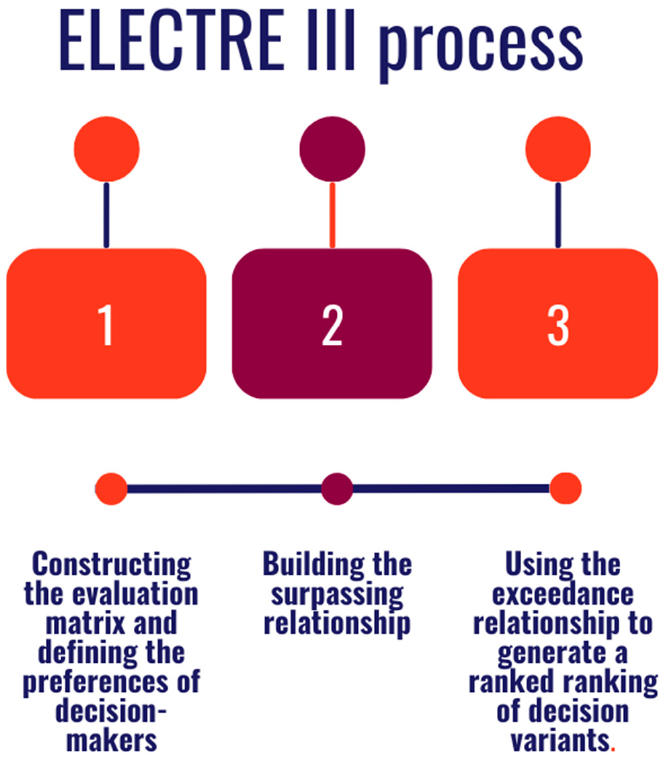
Figure 1. ELECTRE III process.